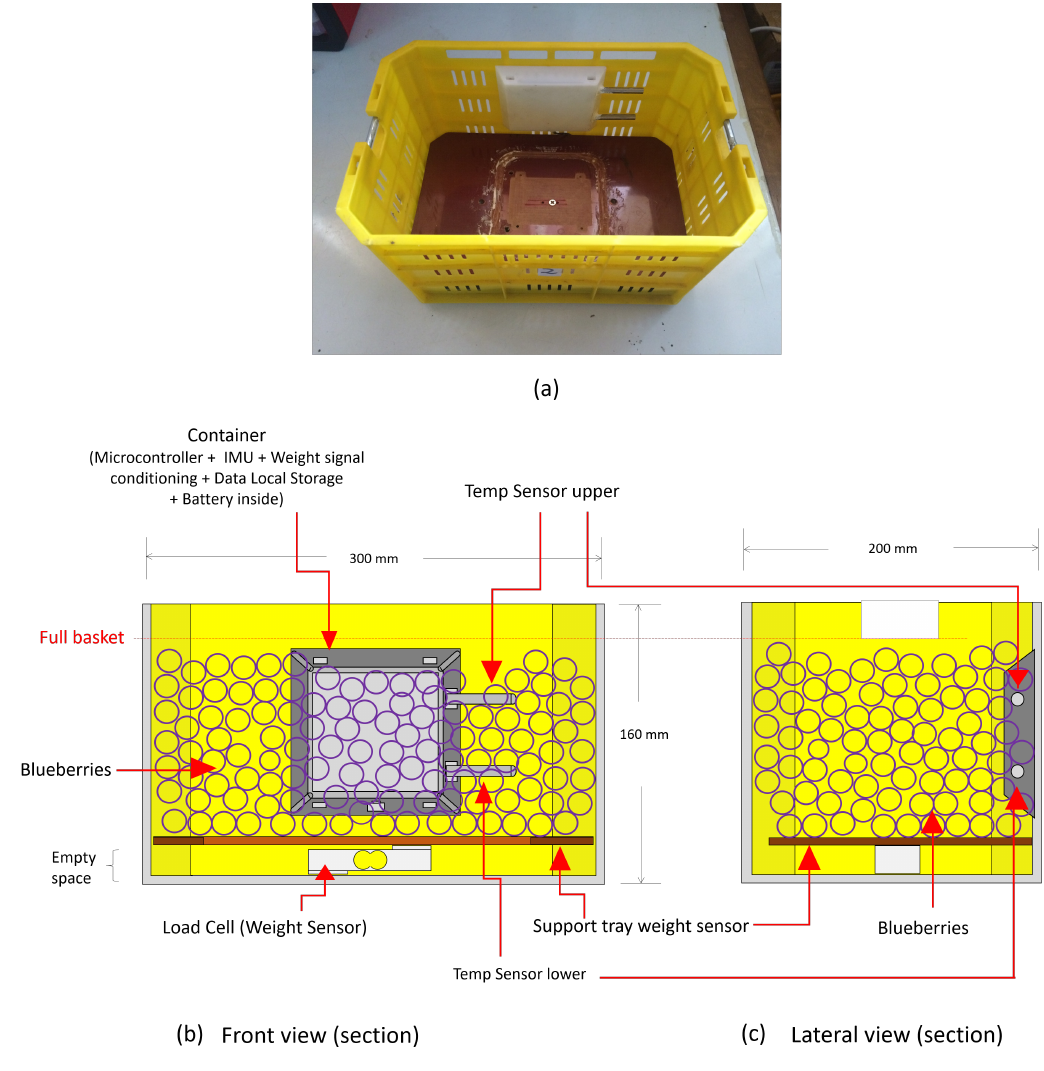
Figure 3. Basket conditioned to on line measure of weight, two temperatures and accelerations; ( a ) basket view, ( b ) schematic front view and ( c ) schematic lateral